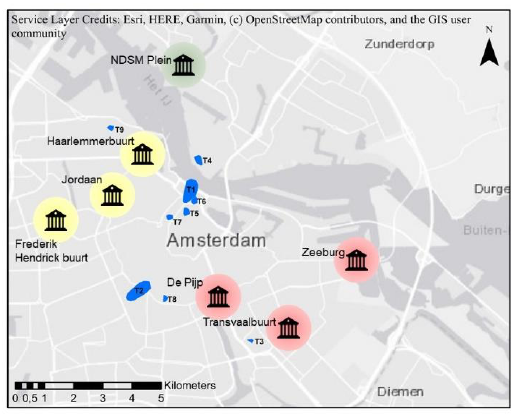
Figure 7. Potential heritage POIs to be promoted for tourist visitations (yellow: culture-education; red: commercial- governmental; green: recreational